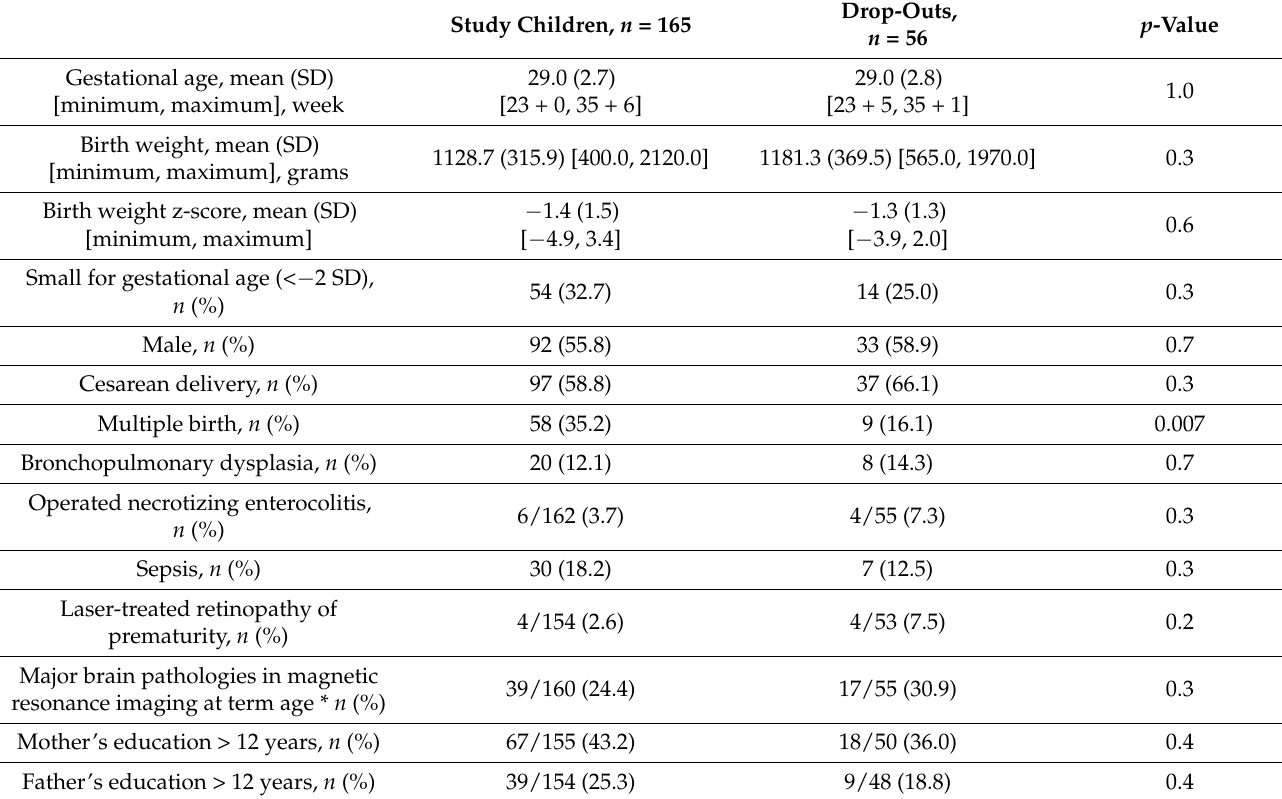
Table 1. Background characteristics of the study children born very preterm (birth weight ≤ 1500 g and or gestational age < 32 weeks) compared with the characteristics of the drop-outs (including two children who died). Continuous variables were compared between the study children and the drop- outs using the independent sample t -test or Mann–Whitney U -test and comparisons between two categorical variables were done using the Pearson Chi Square or Fisher’s exact test, as appropriate. Study Children, n =